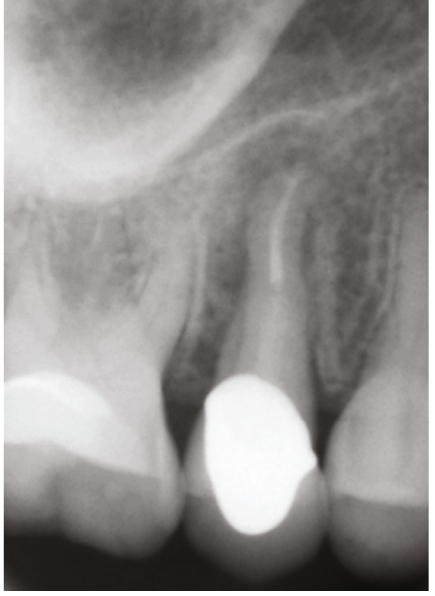
Figure 6: Development of clinical symptoms 9 years after crown delivery: the radiograph revealed a periapical radiolucency, with widening of periodontal ligament/lamina dura modi fi